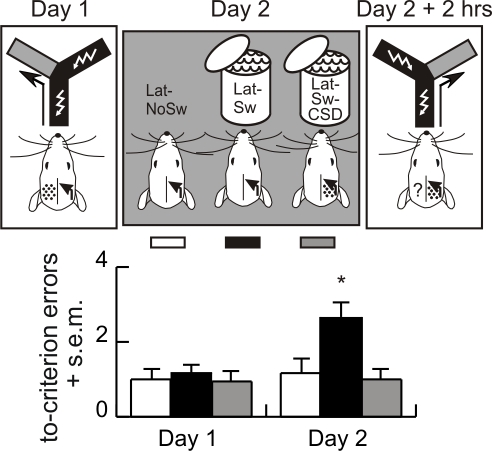
Experiment 7—Swim-induced interhemispheric transfer of lateralized memory.The intensive training protocol was administered under unilateral CSD (shading) on Day 1, which led to the formation of a lateralized left/right discrimination memory (arrow). The next day the forced swim was administered with an intact brain in group Lat-Sw (black, n = 25) and under CSD in the opposite hemisphere as during training in group Lat-Sw-CSD (gray, n = 13). The rats of Lat-NoSw group (white, n = 11) were only handled. Two hours later, reversal training was used to test the expression of memory with the originally trained hemisphere inactivated by CSD and the untrained side (question mark) functional. The average numbers of to-criterion (4/4) errors on Days 1 and 2 are presented. There were significant effects of group (F2,46 = 5.9; p = 0.005), day (F1,46 = 4.1; p = 0.05), and the interaction (F2,46 = 3.2; p = 0.05). On Day 1 the groups did not differ. On Day 3 the error scores were greater in the Lat-Sw group compared to the Lat-CSD-Sw and Lat-NoSw groups (F2,46 = 6.5; p = 0.003; post hoc, both ps <0.05), which were similar (* p<0.05). The data indicate the 1-d-old memory was activated by the swim.